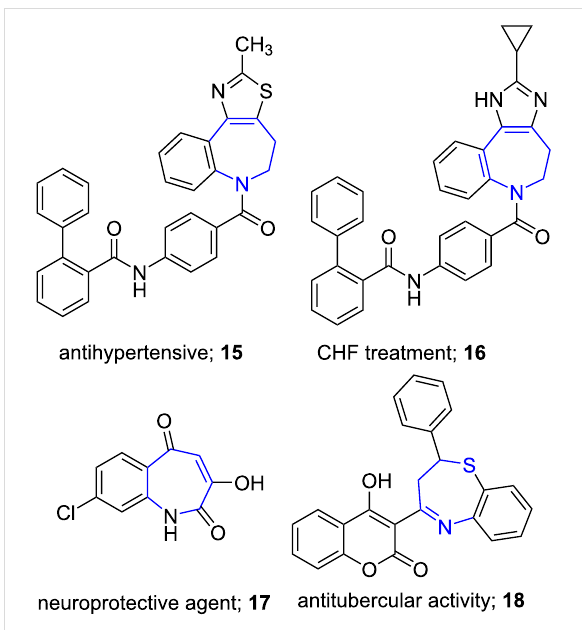
In 2011, Van der Eycken and co-workers [45] tailored a micro- wave-assisted multicomponent reaction for fast and efficient generation of diastereoselective dibenzo[ c , e ]azepinones. The protocol utilized substituted 2'-formylbiphenyl-2-carboxylic acid 19 , benzylamines 20 , and isocyanides 21 in TFE and Na 2 SO 4 as drying agent for the construction of azepinone 22 and exemplified a modified Ugi reaction (four-component reac- tion). The aldehyde and acid component of the Ugi reaction was functionalized on the same biaryl ring employing